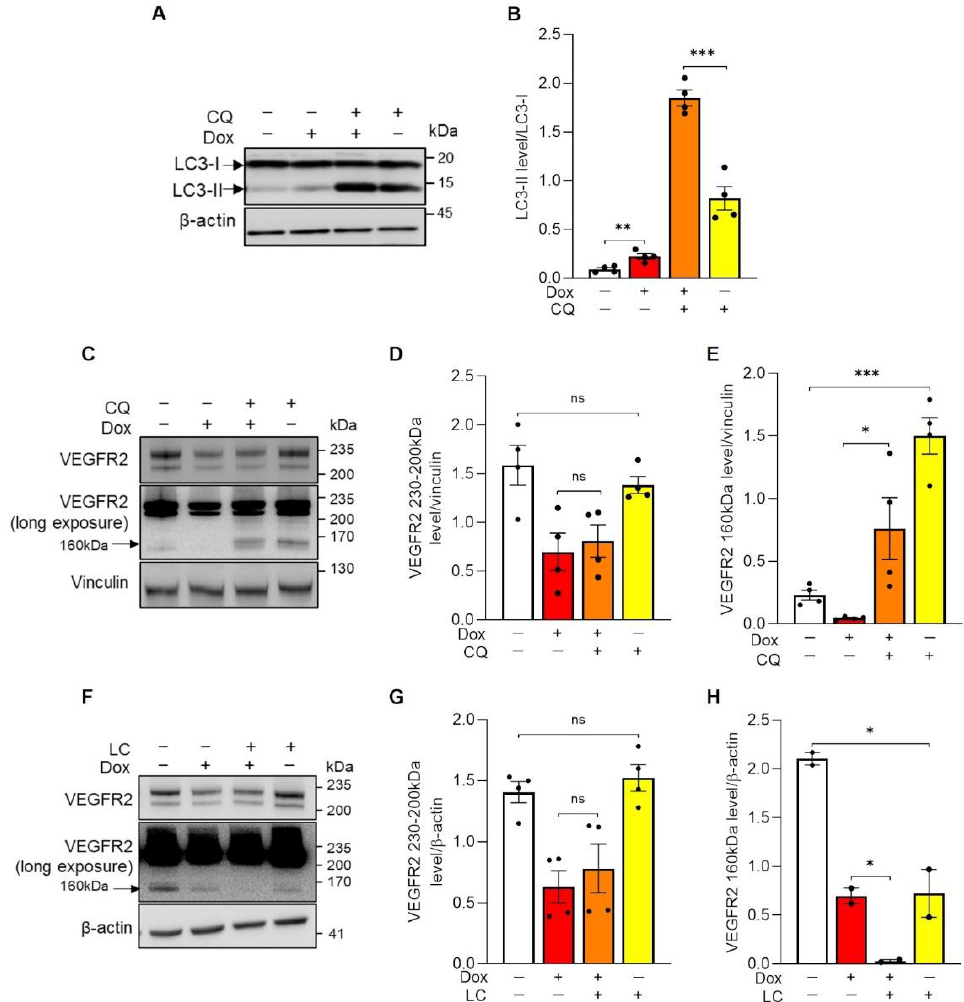
Figure 3. Doxorubicin-induced VEGFR2 reduction is not due to an increased degradation. ( A – E ) HUVECs were incubated with 250 nM Doxorubicin in absence or presence of 50 µ M Chloroquine (CQ). After 16 h, cells were lysed and analyzed by immunoblotting with indicated antibodies. ( A ) Representative immunoblot. Arrows indicate the LC3-II and LC3-I forms. ( B ) Quantification of LC3 protein level by densitometric analysis. Data are shown as mean ± SEM of LC3-II level normalized to LC3-I. n = 4 independent experiments per condition. ** p < 0.01, *** p < 0.001 by unpaired Student’s t test. ( C ) Representative immunoblot. Arrow indicates the cleaved form of VEGFR2 in the same long-exposed blot. ( D , E ) Quantification of the mature (VEGFR2 230–200 kDa) and cleaved VEGFR2 (VEGFR2 160 kDa) protein levels by densitometric analysis. Data are shown as mean ± SEM of protein level normalized to vinculin. n = 4 independent experiments per condition. ns p > 0,05, * p < 0.05, *** p < 0.001 by unpaired Student’s t test. ( F – H ) HUVECs were incubated with 250 nM Doxorubicin in absence or presence of 5 µ M Lactacystin (LC). After 16 h, cells were lysed and analyzed by immunoblotting with indicated antibodies. ( F ) Representative immunoblot. Arrow indicates the cleaved form of VEGFR2 in the same long-exposed blot. ( G , H ) Quantification of the mature (VEGFR2 230–200 kDa) and cleaved VEGFR2 (VEGFR2 160 kDa) forms by densitometric analysis. Data are shown as mean ± SEM of protein level normalized to β -actin. n = 2–4 independent experiments per condition. ns p > 0.05, * p < 0.05 by unpaired Student’s t test. Not treated cells = white histogram, Dox = red histogram, Dox + CQ/LC = orange histogram and CQ/LC = yellow